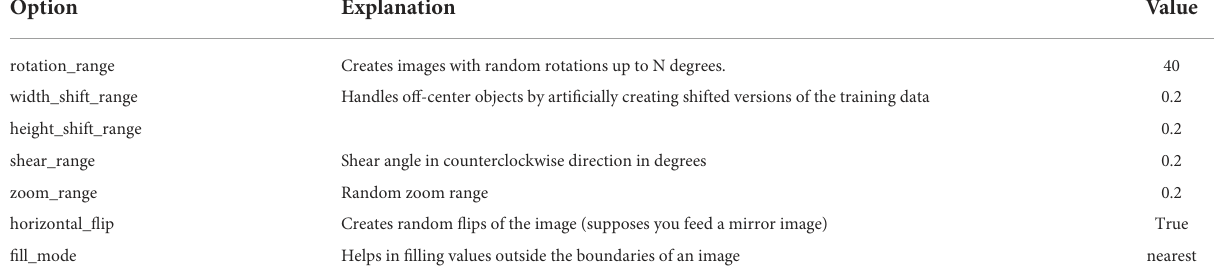
TABLE 2 List of augmentation options and parameter values used in our